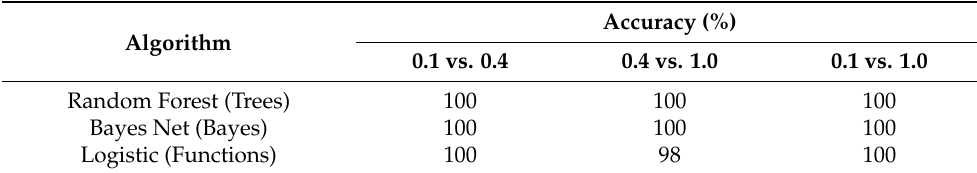
Table 5. The accuracy of distinguishing the ripening stages of ‘Royal Glory’ peaches based on a set of textures selected from flesh images in color channels R , G , B , L , a , b , X , Y , and Z .